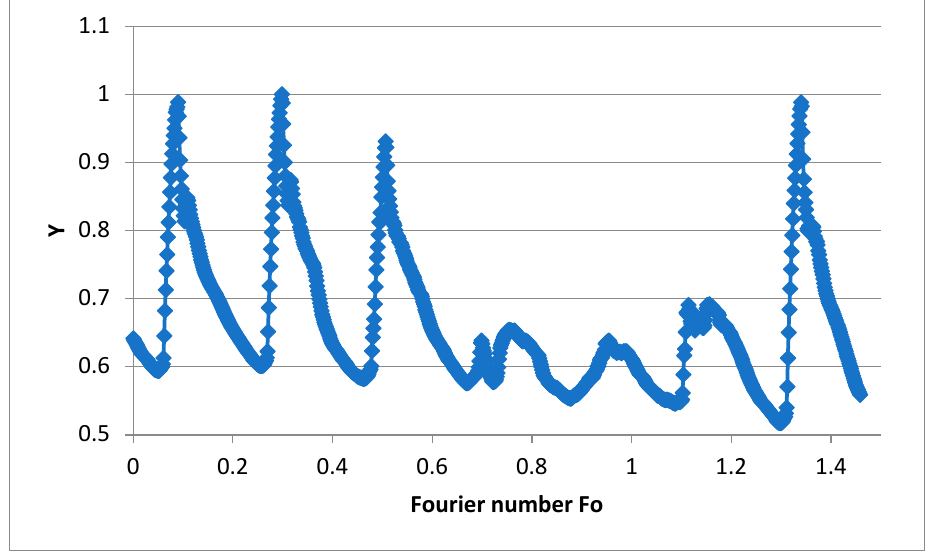
Figure 19. Dimensionless temperature as a function of Fourier number for 4–10 January. The dependence of Y on the Fourier number for 21–27 June is shown in Figure 20.